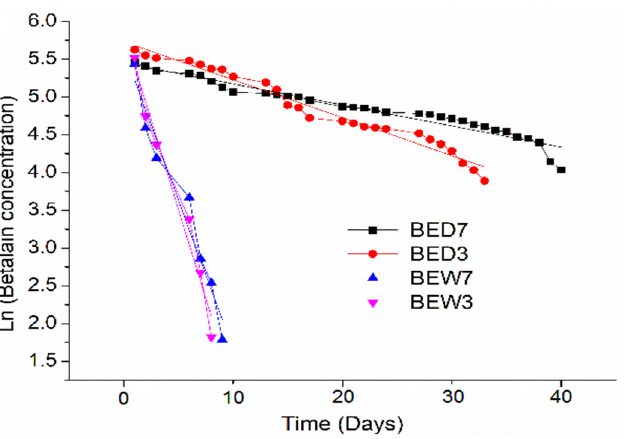
Figure 4. Linear kinetic of betalain degradation from beet DES (BED) and water extracts (BEW) for 40 days of exposure to visible light and environmental temperature (20–27